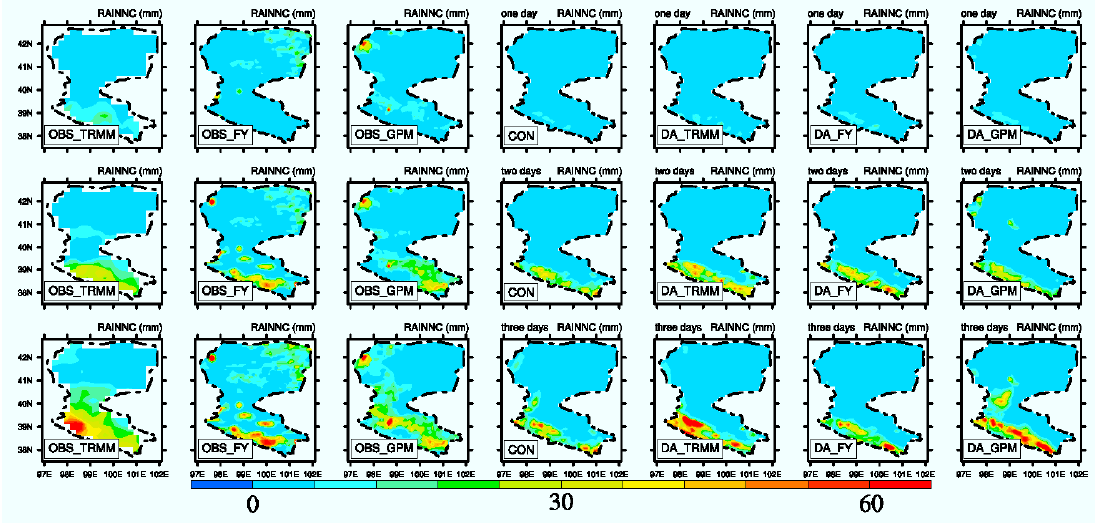
Figure 12. Accumulated precipitation at 24 h, 48 h, and 72 h from 1 July to 3 July 2015 (the assimilation window is from 00:00 UTC to 06:00 UTC, 1 July 2015)